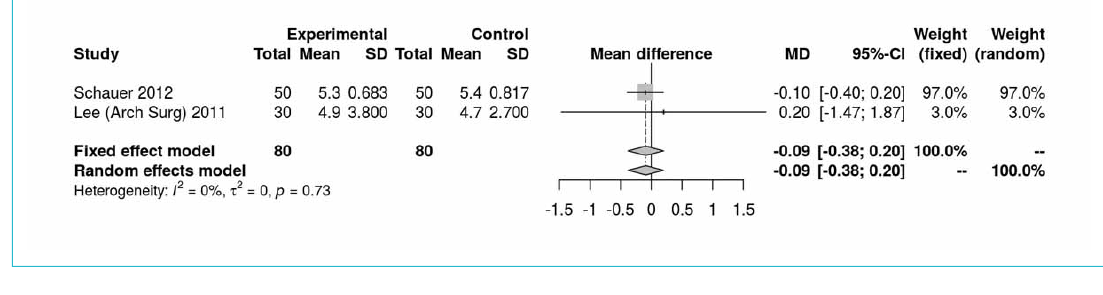
Figure S6e: Insulin at 12 months (analysis of studies including only patients with type 2 diabetes).